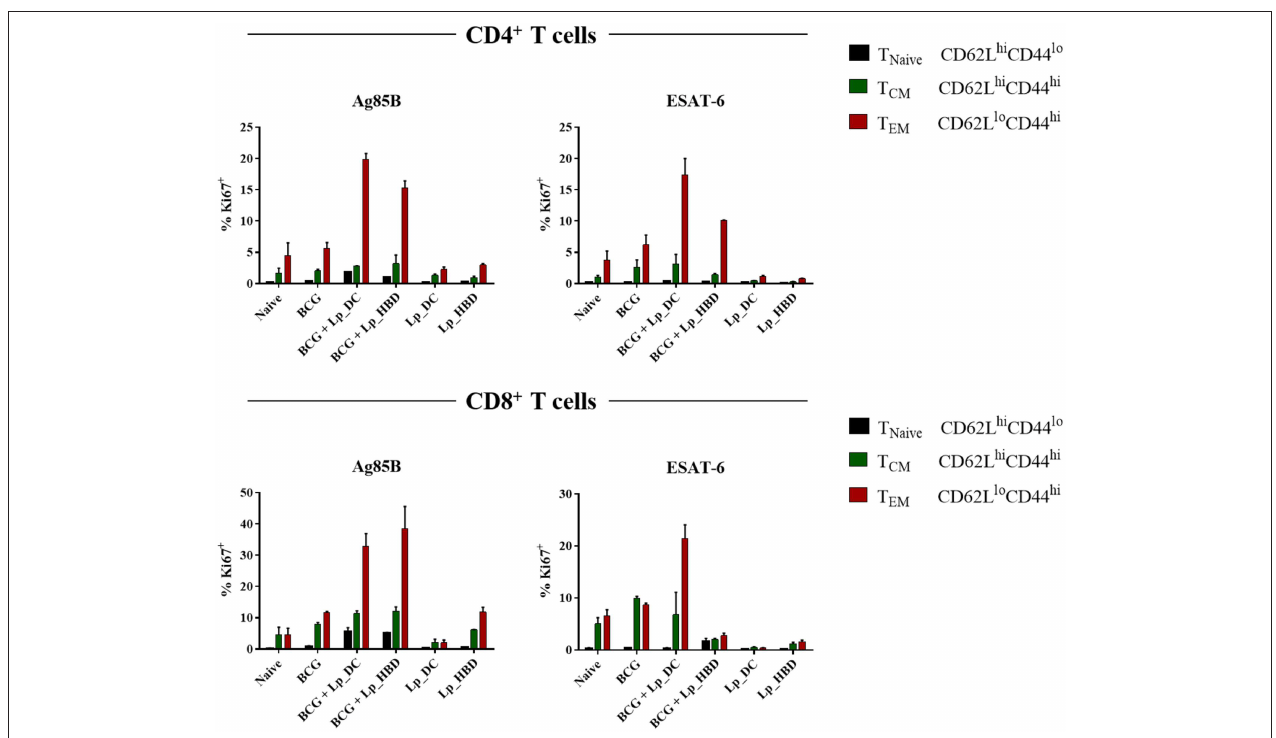
FIGURE 6 | Antigen specific T cell proliferation. Splenocytes from immunized mice were stimulated with Ag85B or ESAT-6 for 6 days. T cell proliferation was analyzed by Ki67 staining using a live → single cells → CD3 + → CD4 + /CD8 + → Ki67 + gating strategy. Central memory T cells (T CM ), effector memory T cells (T EM ) and naive T cells (T Naive ) were determined using CD44 and CD62L staining. Results are presented as a mean ± SEM of technical duplicates and are derived from n = 2–3 pooled spleens per group.